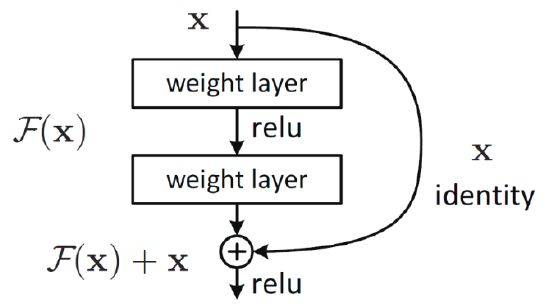
Figure 1. A building block in residual learning (He et al., 2015)